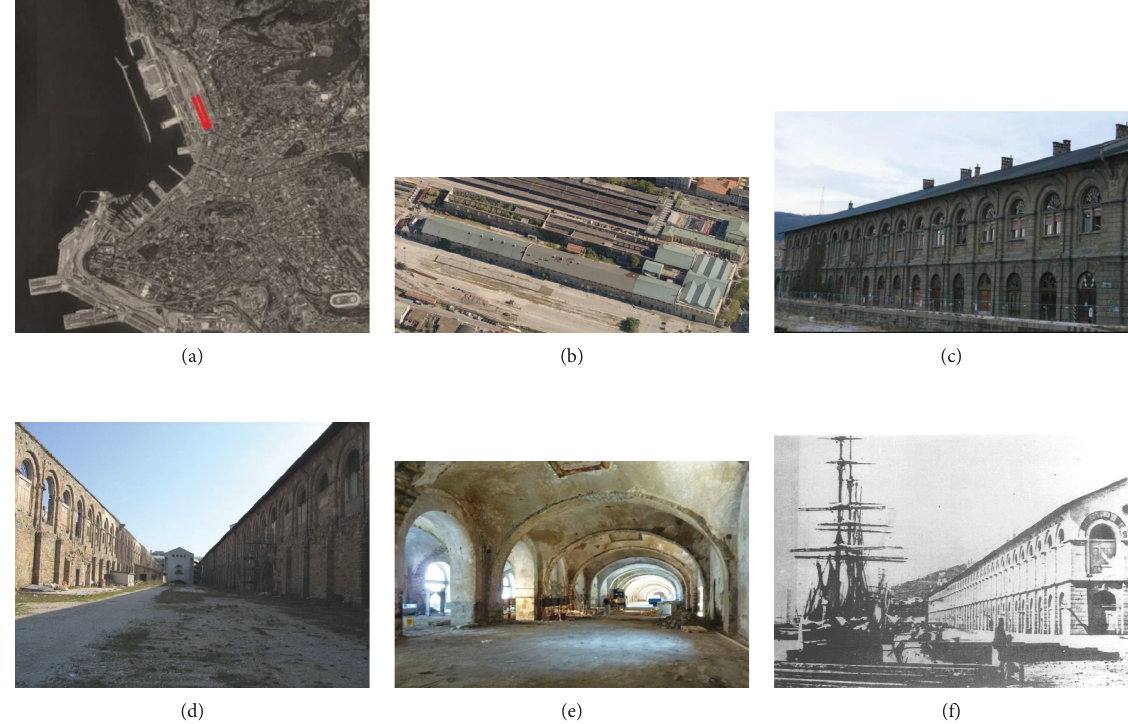
Figure 1: The nineteenth century “ex-Silos” storehouses of Trieste: (a) location in the harbor area; (b) aerial view; (c) lateral (sea side) view; (d) view of inner courtyard; (e) internal view of the arches-vaults system at the ground floor; (f) seaside view of the buildings from an historical ancient